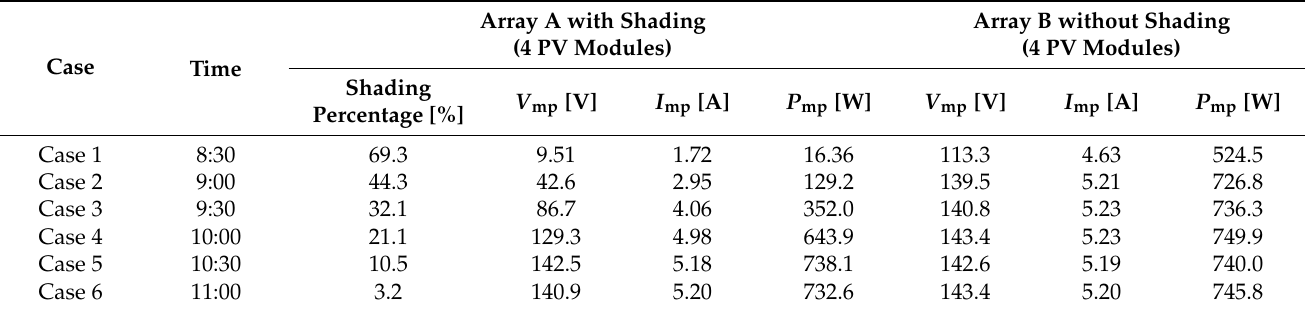
Table 4. Electrical results of PV arrays with and without